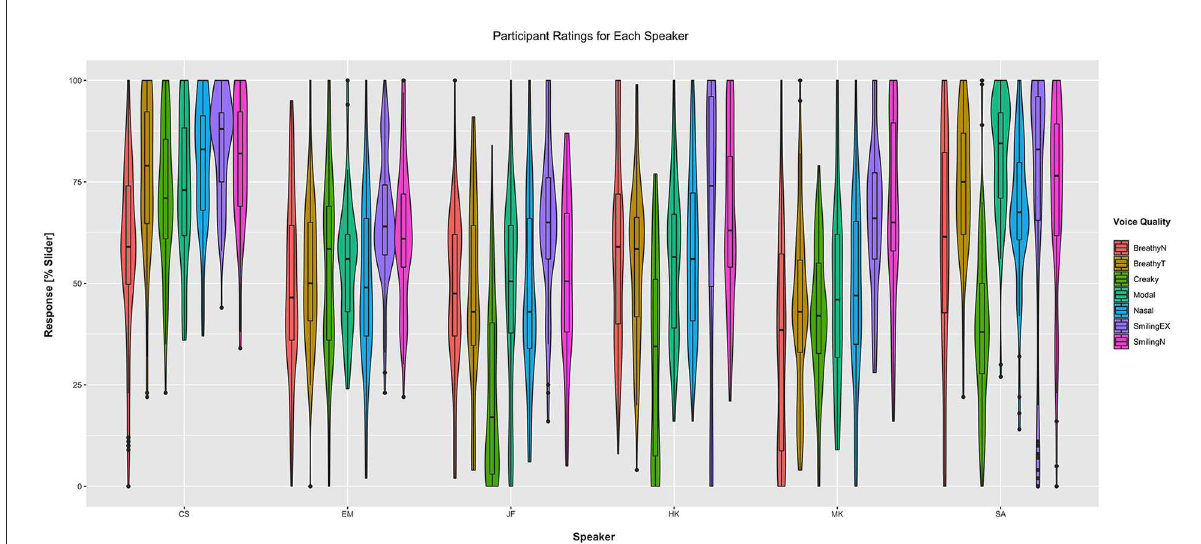
FIGURE2 Voice quality ratings for all listeners, separately shown for each examined speaker (shown on the x-axis; the first three speakers are male, the last three female). The y-axis displays the slider position percentage (0% corresponding to the left extreme value of the slider and 100% to the opposite extreme). The colors represent the various examined vocal qualities. Shown are violin plots with overlaid boxplots.